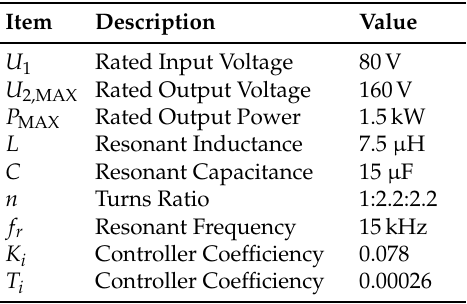
Table 2. Circuit parameters of the